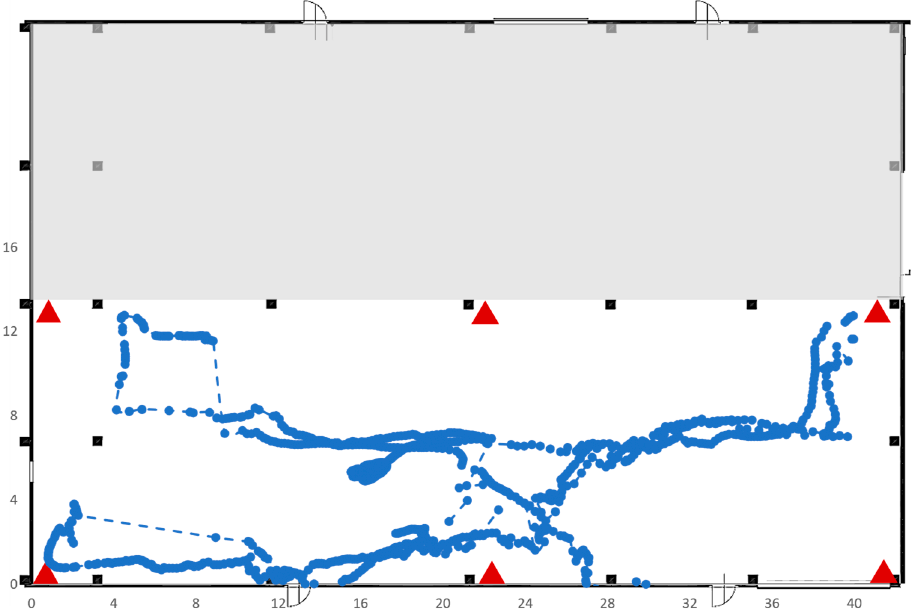
Figure 26. Results of Test 6; tag in the lower position.